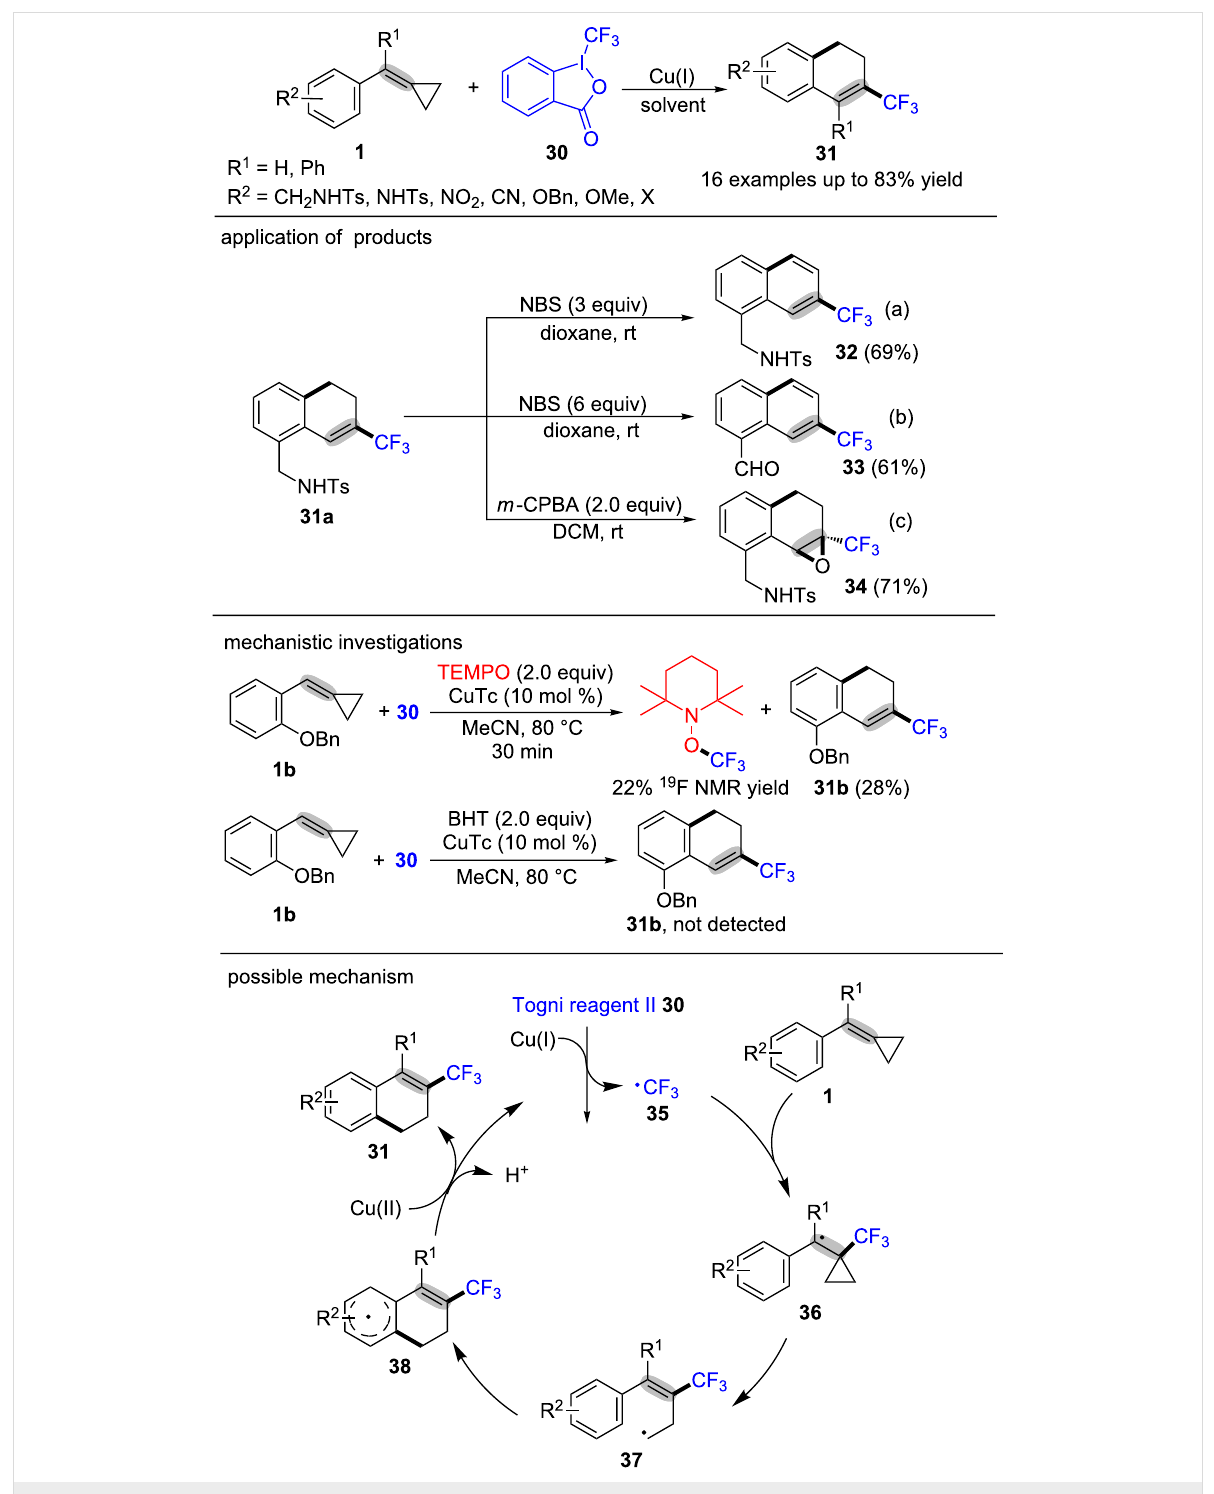
Scheme 9: Copper(I)-catalyzed oxidative radical trifluoromethylation/ring-opening/cyclization of MCPs with Togni reagent II.